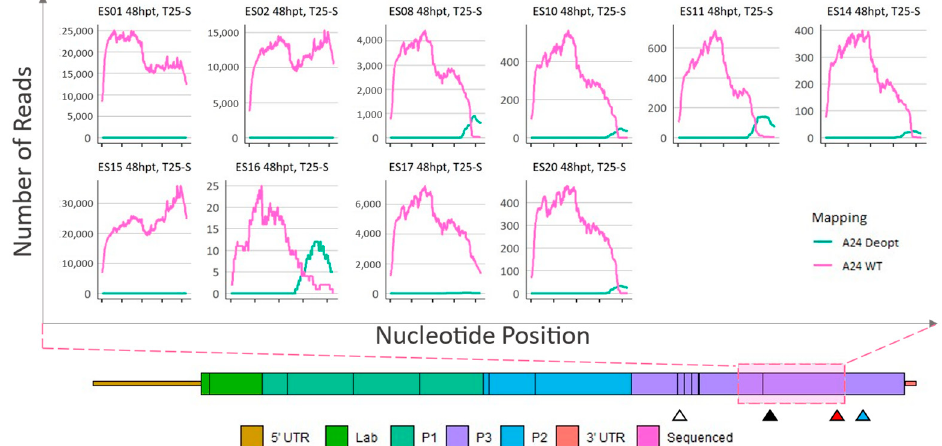
Figure 7. Sequence analysis of total cell culture supernatant of 48-hpt Δ P1-P2P3Deopt × Δ GDD recombinants plaque isolates passed in LFBK- α v β 6 cells. Locations ( x -axis) and counts ( y -axis) of reads that preferentially map to either a A24-WT or A24-P2P3Deopt reference within a 1059 nt section of the 3CD coding region as indicated by the pink shaded box. Triangles indicate the location of the 3B DIVA marker (white), 3D DIVA marker (black), the boundary between deoptimized and non-deoptimized regions (red), and the GDD deletion (blue).